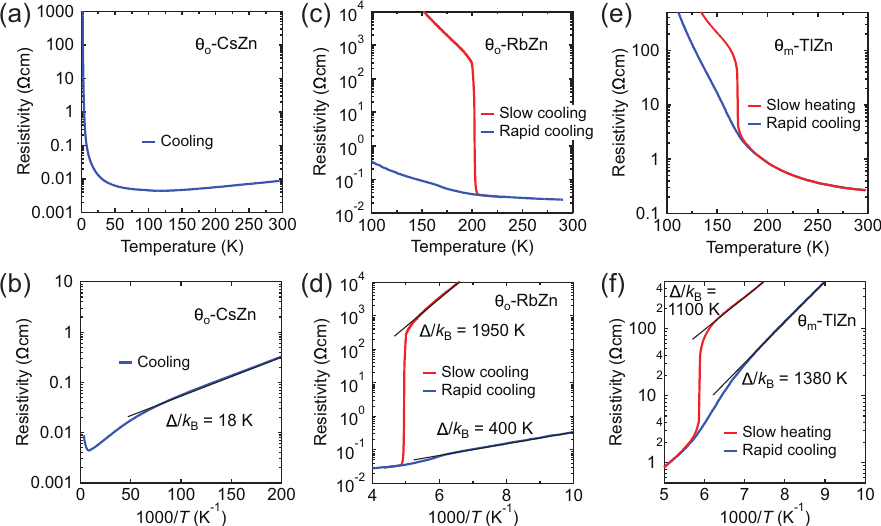
Figure 2. Resistivity and Arrhenius plot in the θ –type salts. ( a ) ρ ( T ) curve of θ o -CsZn measured during cooling. ( b ) Arrhenius plot of the same data in ( a ). ( c ) ρ ( T ) curve of θ o -RbZn measured during rapid cooling of 30K/min (blue) and slow cooling of 0.1K/min (red). ( d ) Arrhenius plot of the same data in ( c ). ( e ) ρ ( T ) curve of θ m -TlZn measured during rapid cooling of 100K/min (blue) and slow heating after slow cooling of 0.1K/min (red). ( f ) Arrhenius plot of the same data in ( e ). The black lines in ( b , d , f ) represent the fits to ρ ∝ exp ( ∆ / ( k B T ))